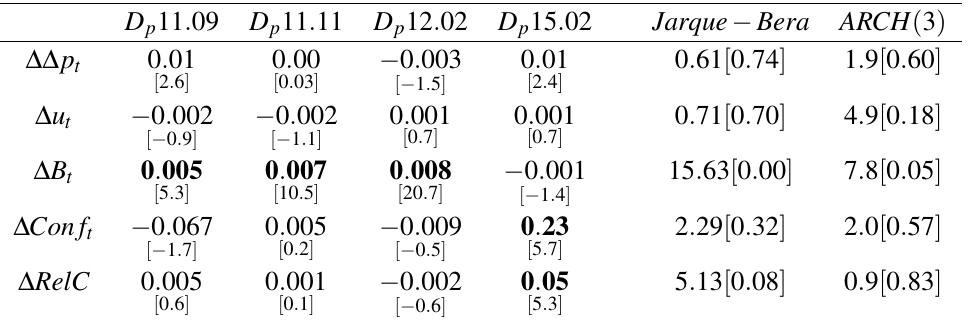
Table 1: Dummy variables and misspecification